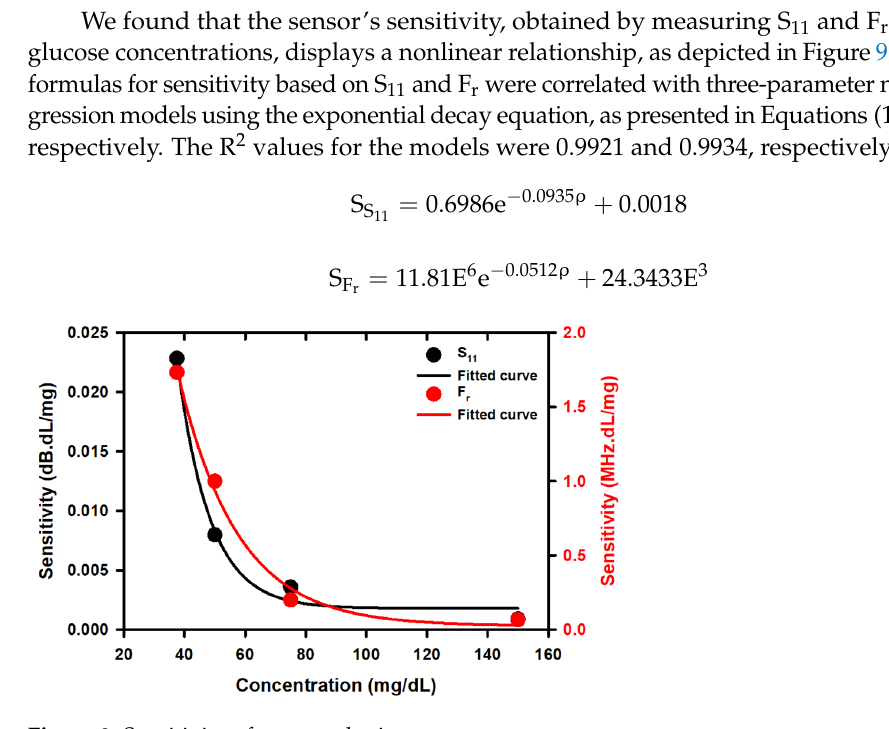
Figure 9. Sensitivity of proposed microwave sensor.